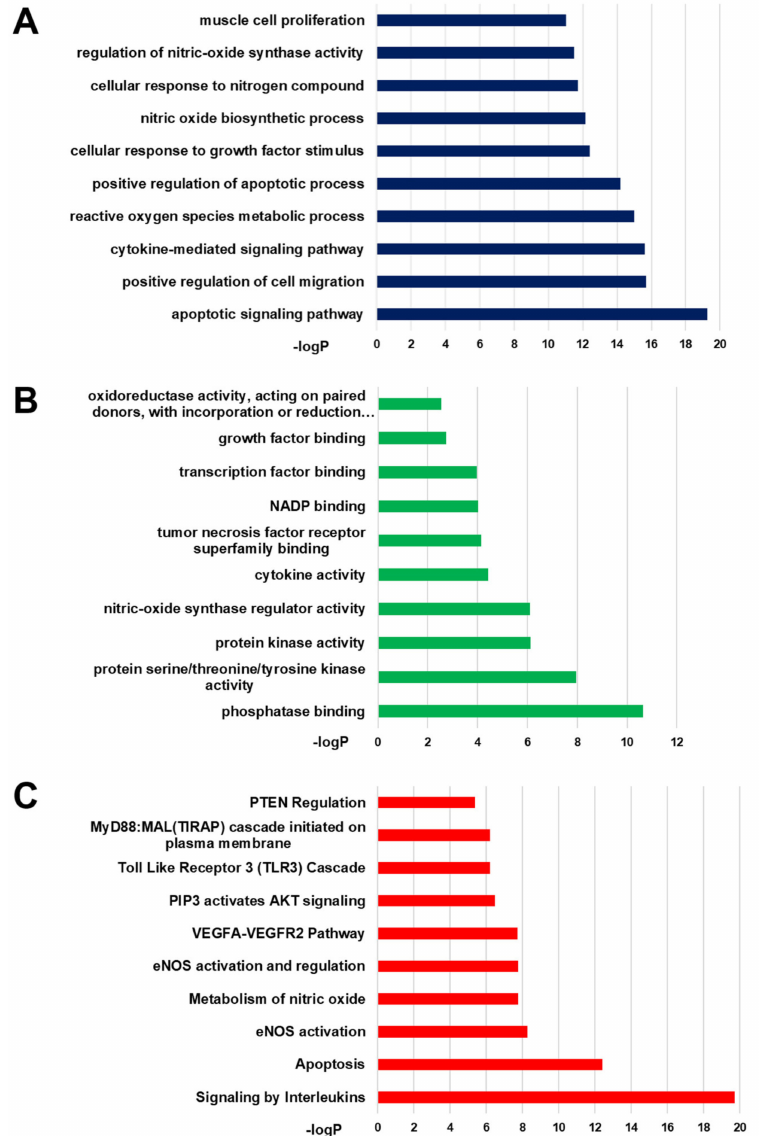
Figure 2. Gene Ontology (GO) analysis and Reactome pathway analysis of genistein targets. The y-axis shows significantly enriched ( A ) “Biological Process” (BP) categories, ( B ) “Molecular function” (MF) categories and ( C ) “Reactome Gene Sets” associated with the targets; the x-axis shows the enrichment scores of these